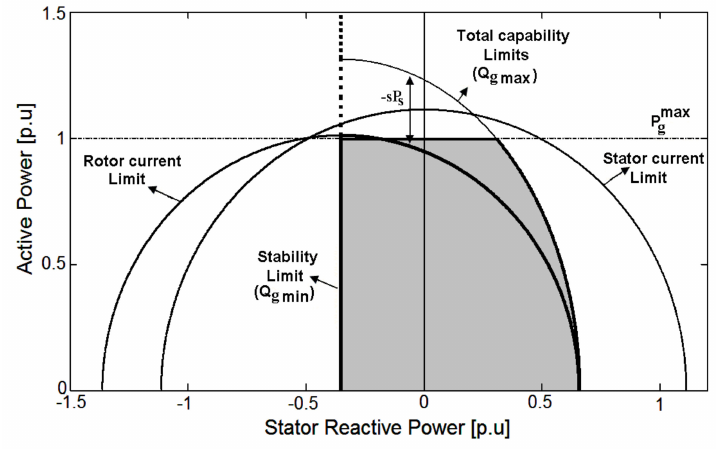
Figure 1. Doubly fed induction generator (DFIG) capability